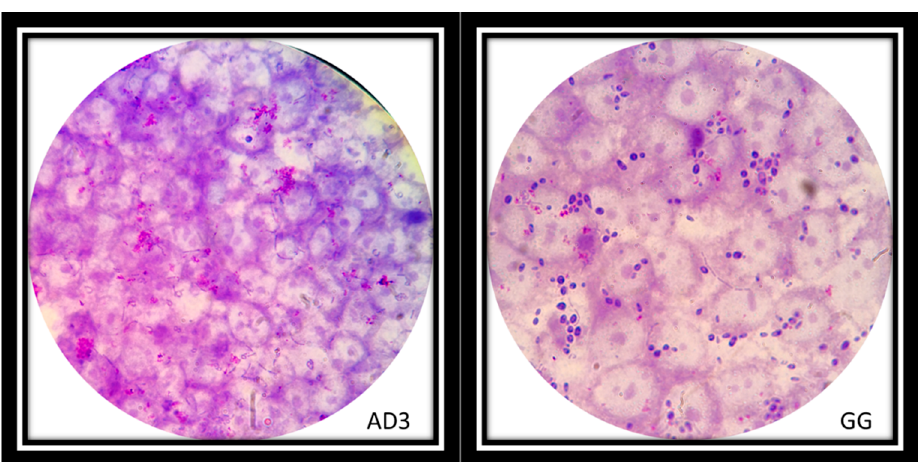
Figure 8. L. rhamnosus AD3 on Hep ‐ 2 cell monolayer inhibited adhesion of Candida on epithelial cells (AD3). Instead, the adhesion of L. rhamnosus GG on the Hep ‐ 2 monolayer did not inhibit the adhesion of the Candida (dark purple cells) (GG). Strains were observed under the microscope (1000 × ) after Giemsa staining.